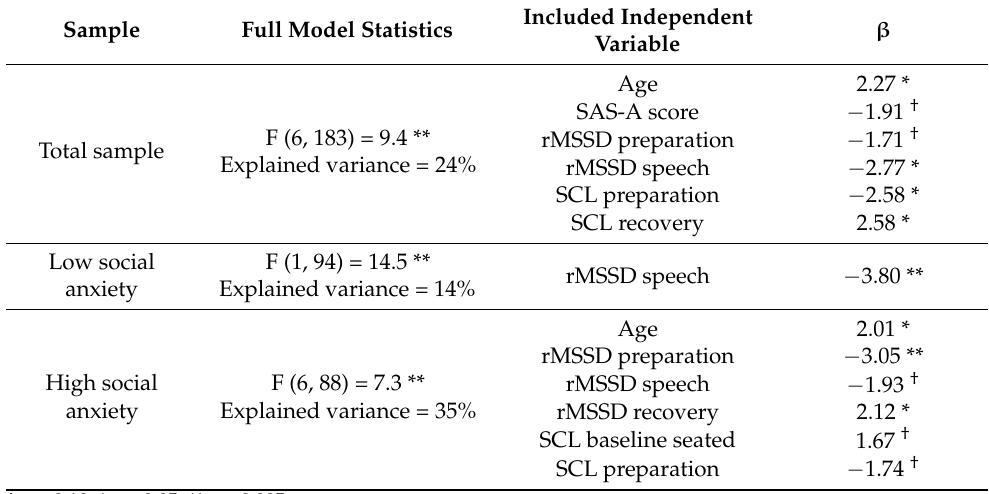
Table 2. Predictors of cortisol AUC in the total sample and in the low- and high-anxiety groups. Sample